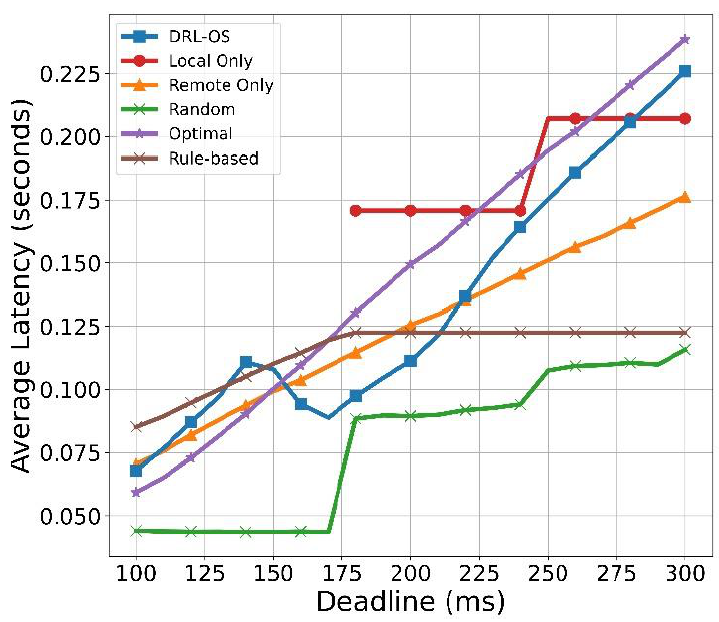
Figure 15. Average latency vs. deadline.